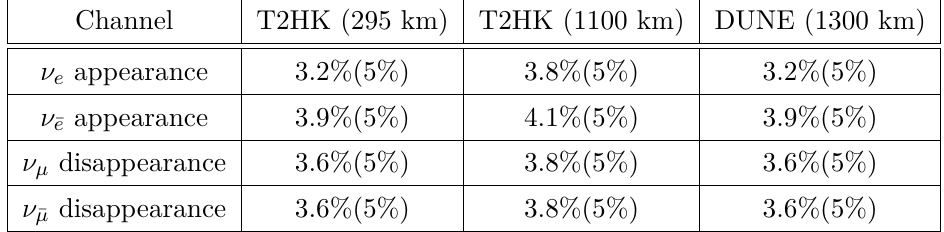
have used the oscillation parameter values as listed in table 1. Unless otherwise mentioned, we considered NH to be the true mass hierarchy and HO to be the true octant. The effects of the diagonal scalar NSI elements η (left-column), η (middle-column) ee µµ and η (right-column) on P as a function of neutrino energy are shown in figure 1. The ττ µe plots corresponding to the baselines of DUNE (top-row), T2HK (middle-row) and T2HKK (bottom-row) are shown here. The probabilities are calculated for δ = − 90 ◦ and θ = 47 ◦ . 23 CP In all the plots, the solid-red line represents the case without scalar NSI i.e. η = 0 . The αβ solid (dashed) lines in black, blue and magenta are for the chosen positive (negative) η , ee